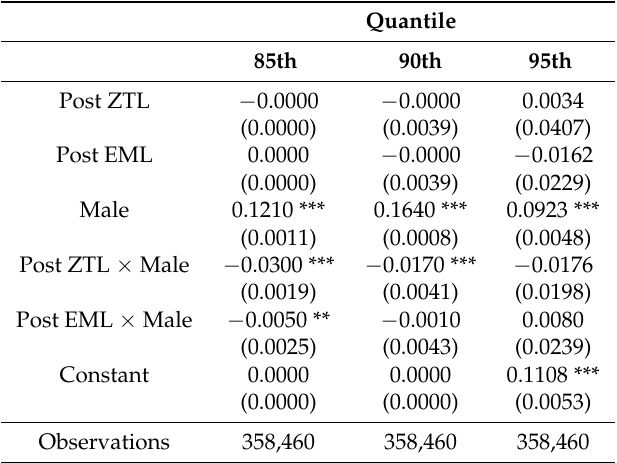
Table 5. Censored Quantile